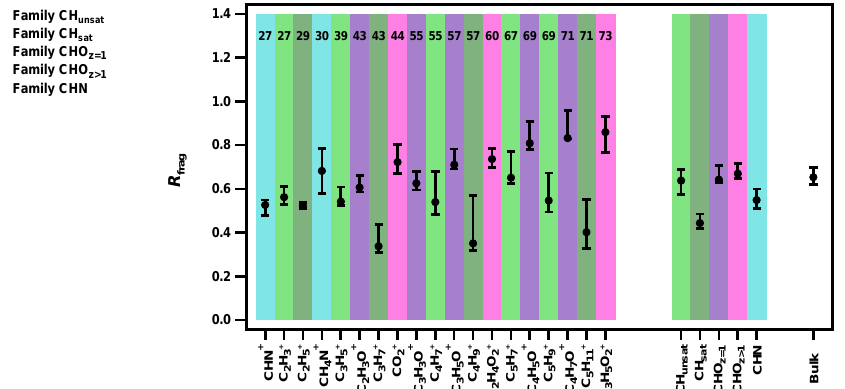
Figure 5. Median recovery of single organic fragments, and chemical families for the Zurich spring campaign (offline vs. online PM 2 . 5 AMS). The first and third quartiles of the inter-sample variability are shown as error bars. A ratio of 1 indicates a recovery of 100%. The fragments are color-coded with the family (CH (hydrocarbon fragments, split into saturated and unsaturated), CHO z = 1 and CHO z> 1 (oxygenated fragments), and CHN, nitrogen-containing hydrocarbon fragments). Numbers across the top of the plot indicate the fragments’ nominal mass. Families include all respective fragments weighted by their mass